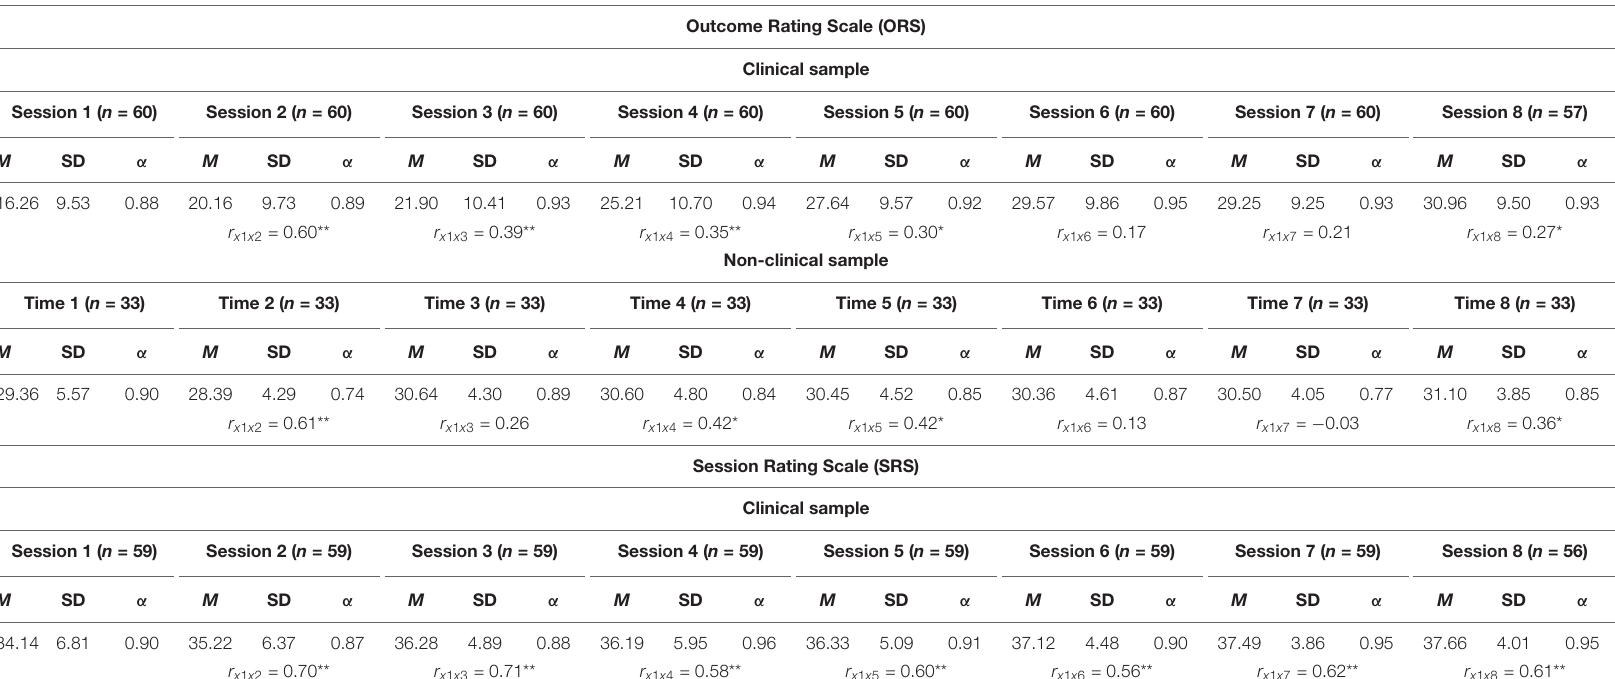
TABLE 2 | Mean scores, standard deviations, alpha coefficients, and stability coefficients of the Spanish versions of the Outcome Rating Scale (ORS) and the Session Rating Scale (SRS).